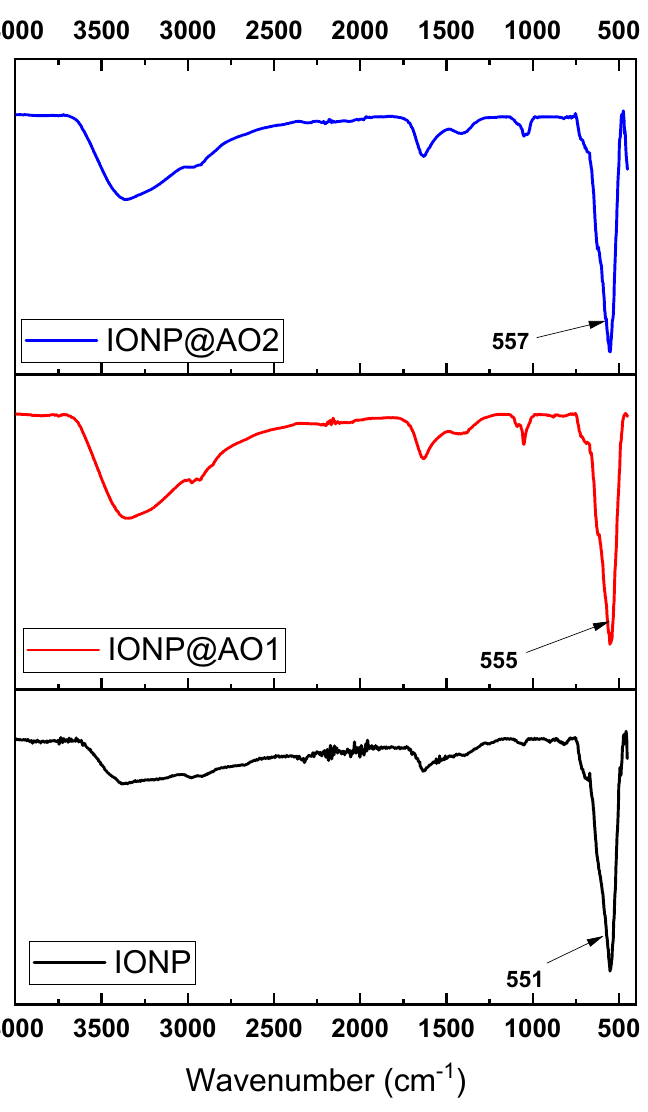
Figure 3. FTIR spectra of unfunctionalized IONP and functionalized IONP@AO.